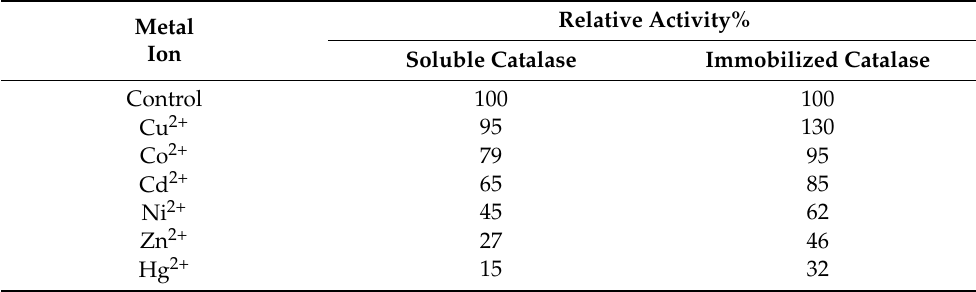
Table 2. The effect of 5 mM metal cations on the soluble and the immobilized catalase.